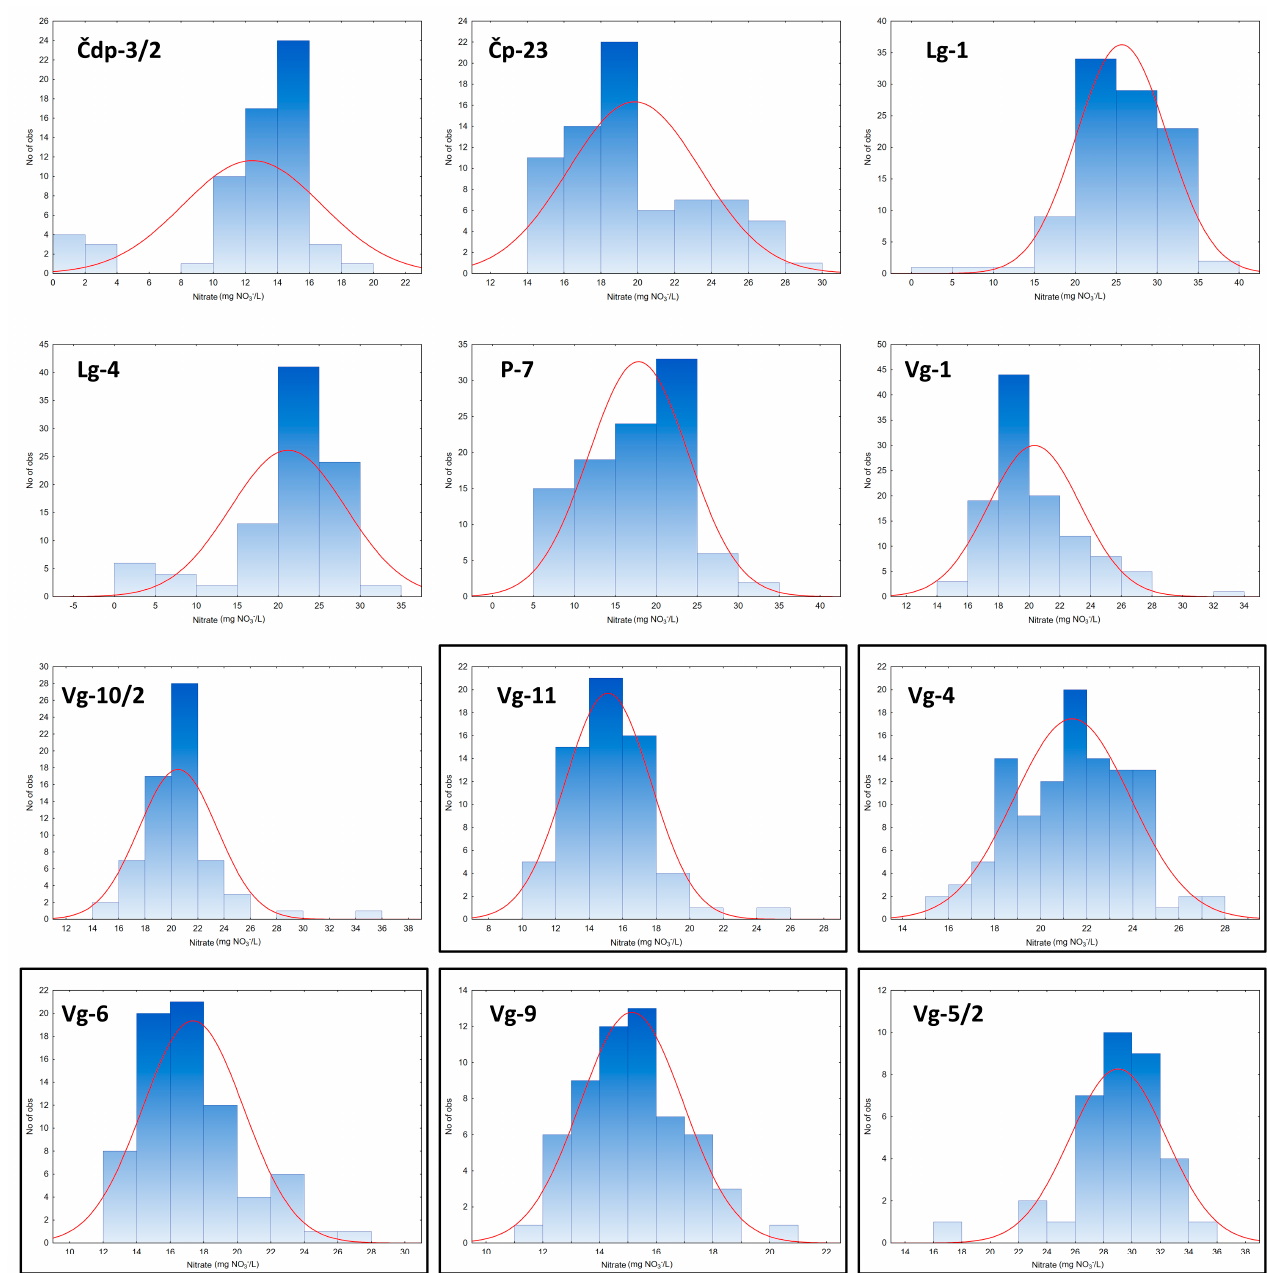
Figure 4. Histograms and normal distribution curves. Normally distributed data are bolded.